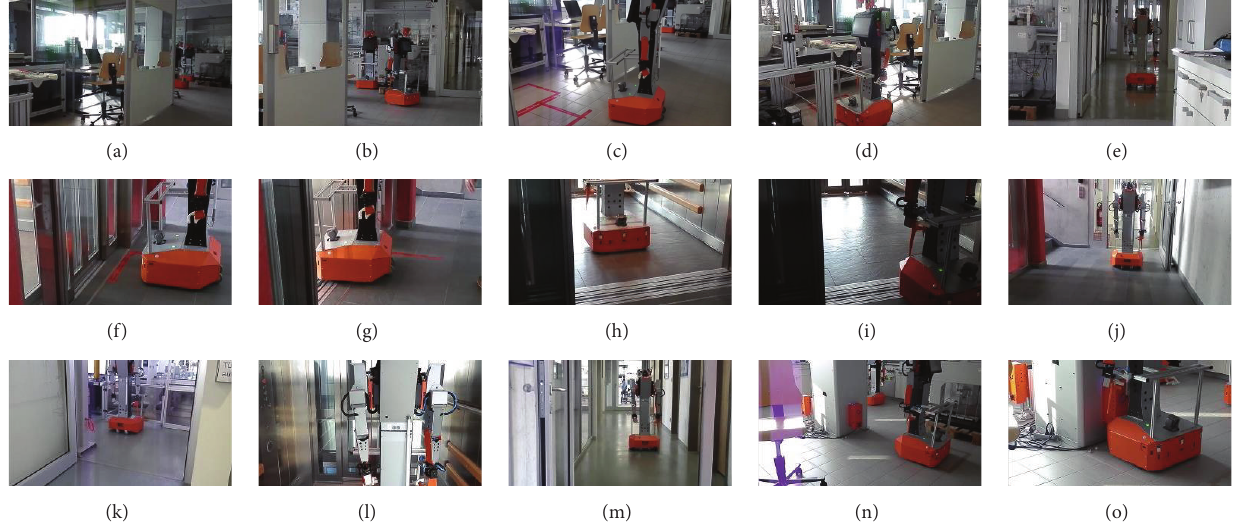
Figure 12: Transportation task in multifloor environment execution.